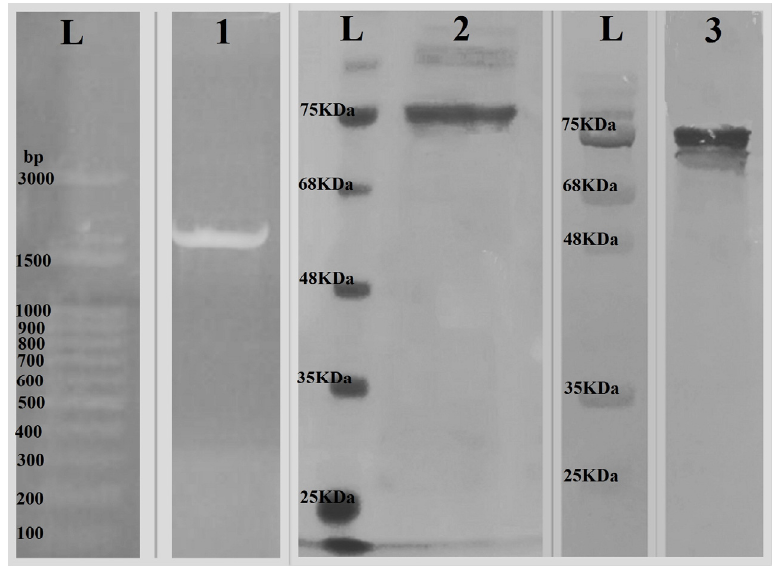
Figure 2. (1) Confirmation of the presence of the GPEHT gene in the transformed colonies (~2000 bp); (2) SDS PAGE, purification of GPEHT protein (~70 kDa); and (3) Western blot of GPEHT protein (~70 kDa). L: Ladder.